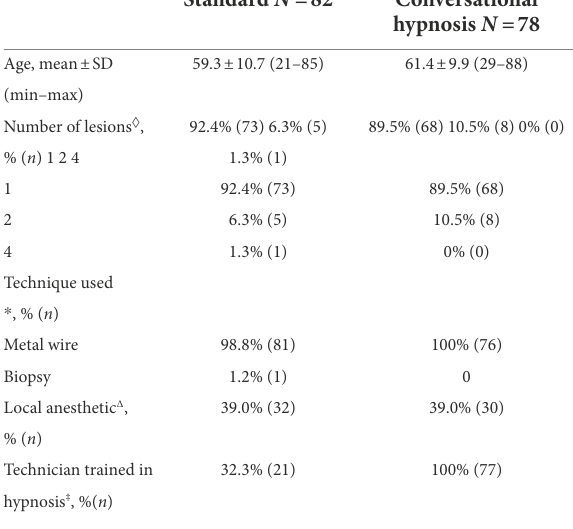
TABLE 1 Characteristics of the patients randomized to the control and conversational hypnosis